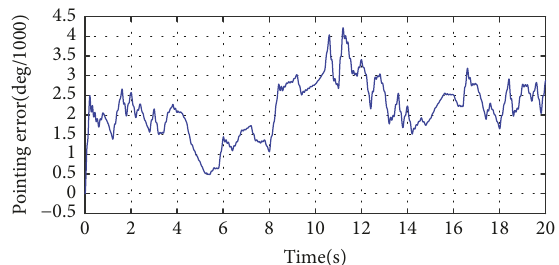
Figure 10: The pointing error caused by deformation of the reflector.